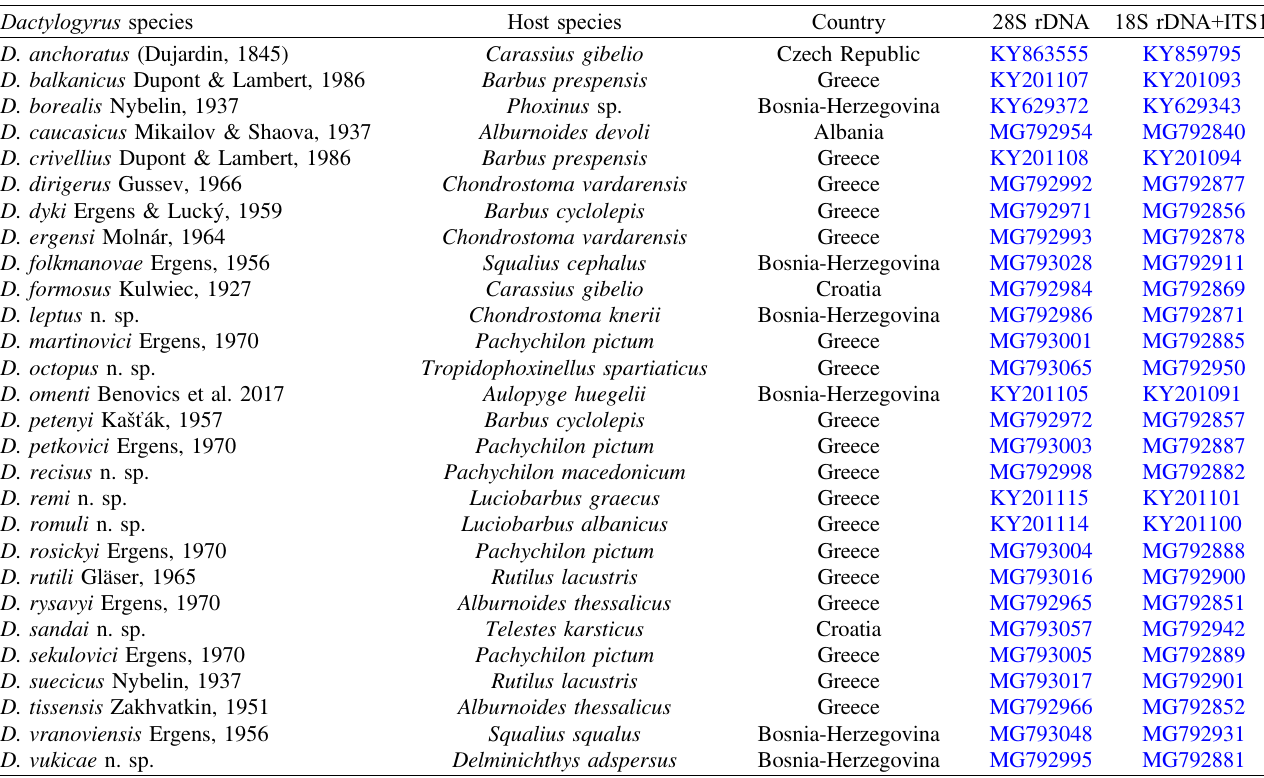
Table 1. List of Dactylogyrus species, their cyprinoid host species, country of collection, and GenBank accession numbers for sequences used for the phylogenetic reconstruction.